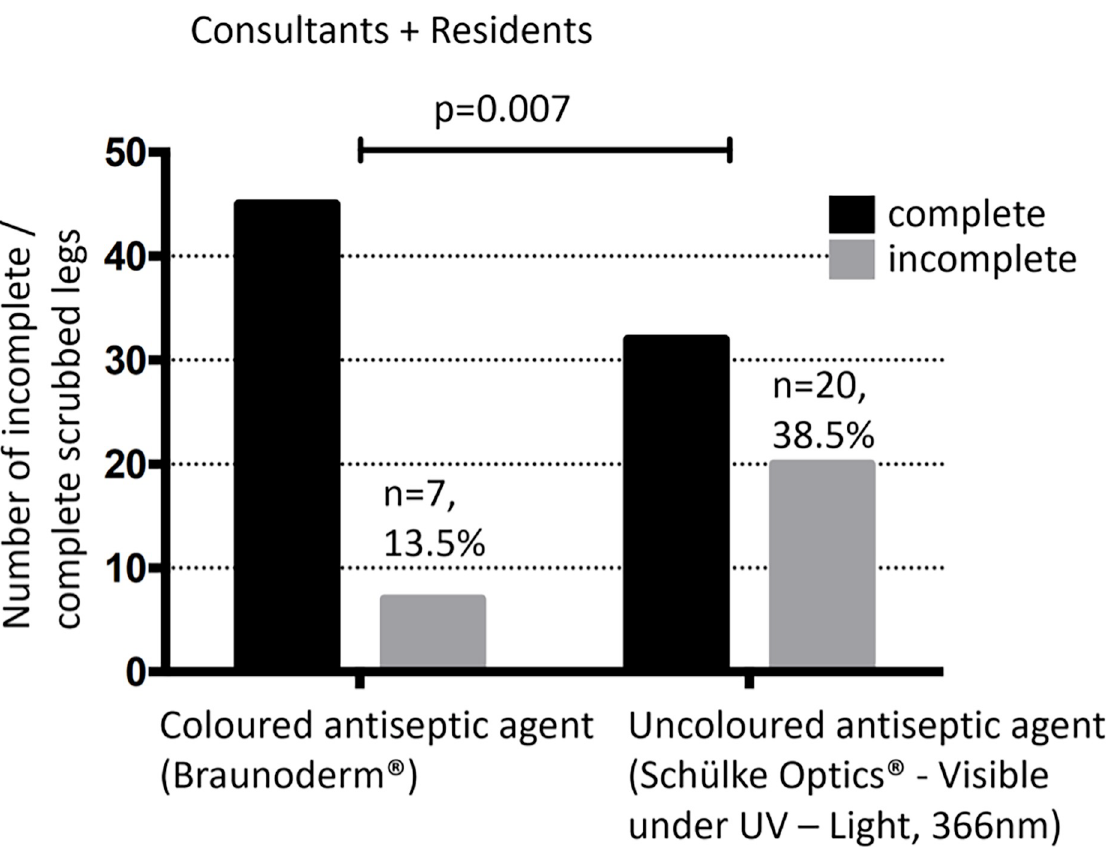
Fig 4. Graph combining the resident and consultant skin preparation completeness based on the number of legs found to have been disinfected